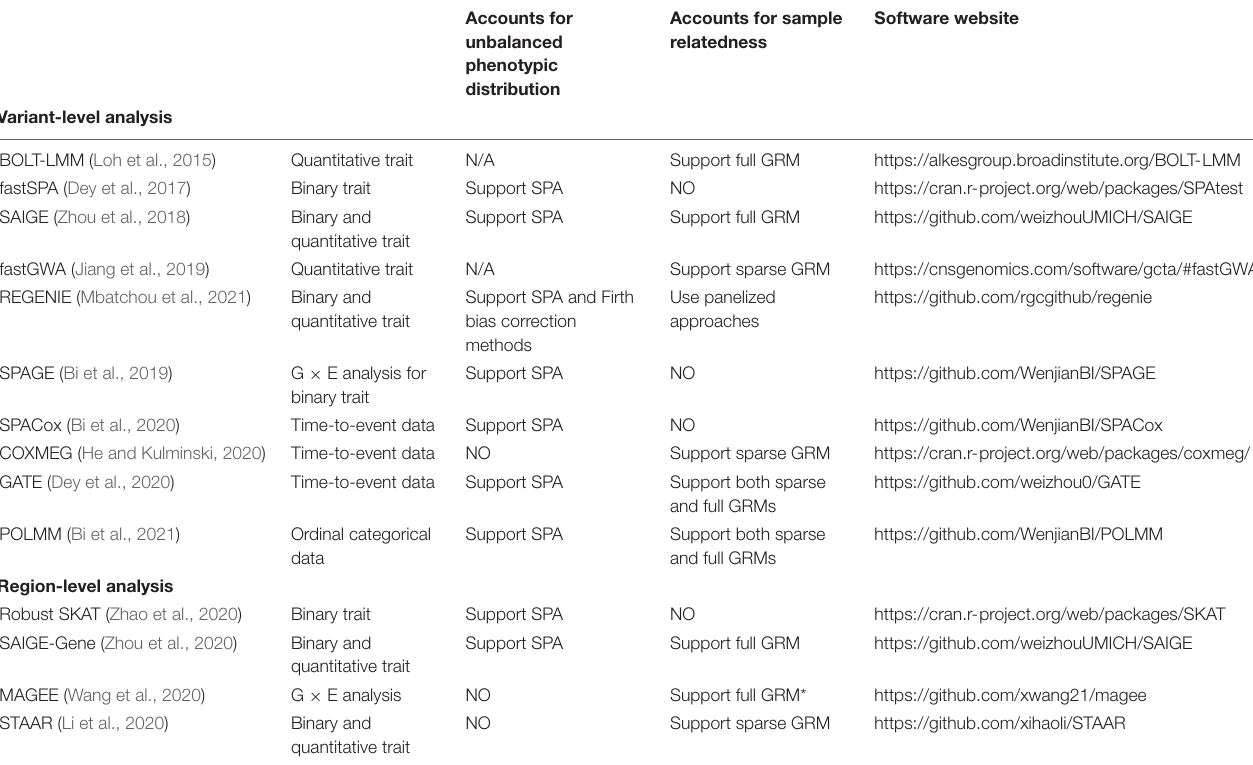
TABLE 2 | Summary of analysis methods and